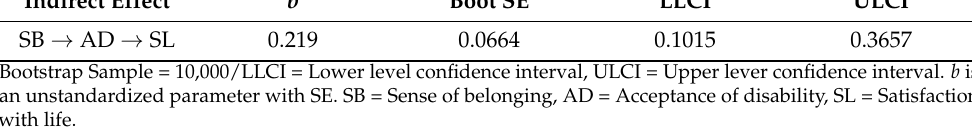
Table 6. Index of indirect effect. Indirect Effect b Boot SE LLCI ULCI SB → AD → SL 0.219 0.0664